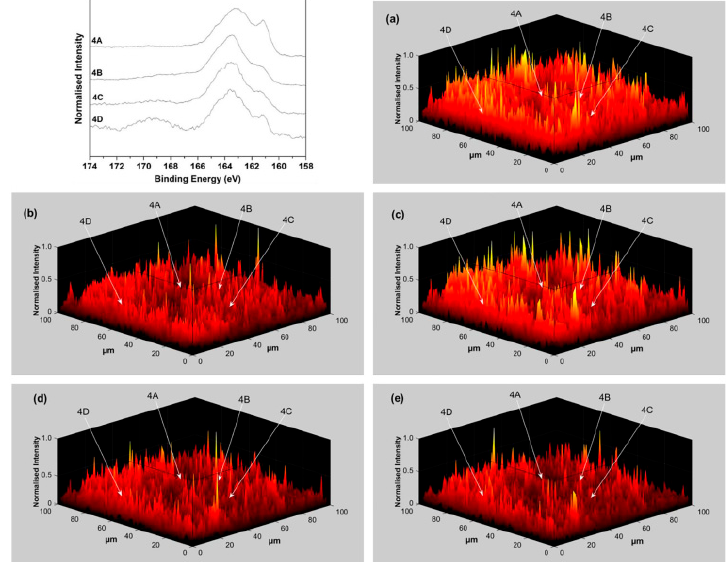
Figure 4 . S 2p SPEM speciation maps (a) S 2- , (b) S 22- , (c) S n2- , (d) S 0 and (e) SO 32- collected from a region Figure 4. S 2p SPEM speciation maps ( a ) S 2 − , ( b ) S 2 2 − , ( c ) S n2 − , ( d ) S 0 and ( e ) SO 3 2 − collected from a region (100 × 100 µ m) on the chalcopyrite surface partially dissolved with pyrite for 10 days containing spots 4A-4D (S 2p XPS spectra are shown in top left corner). Reproduced from [170] with permission from